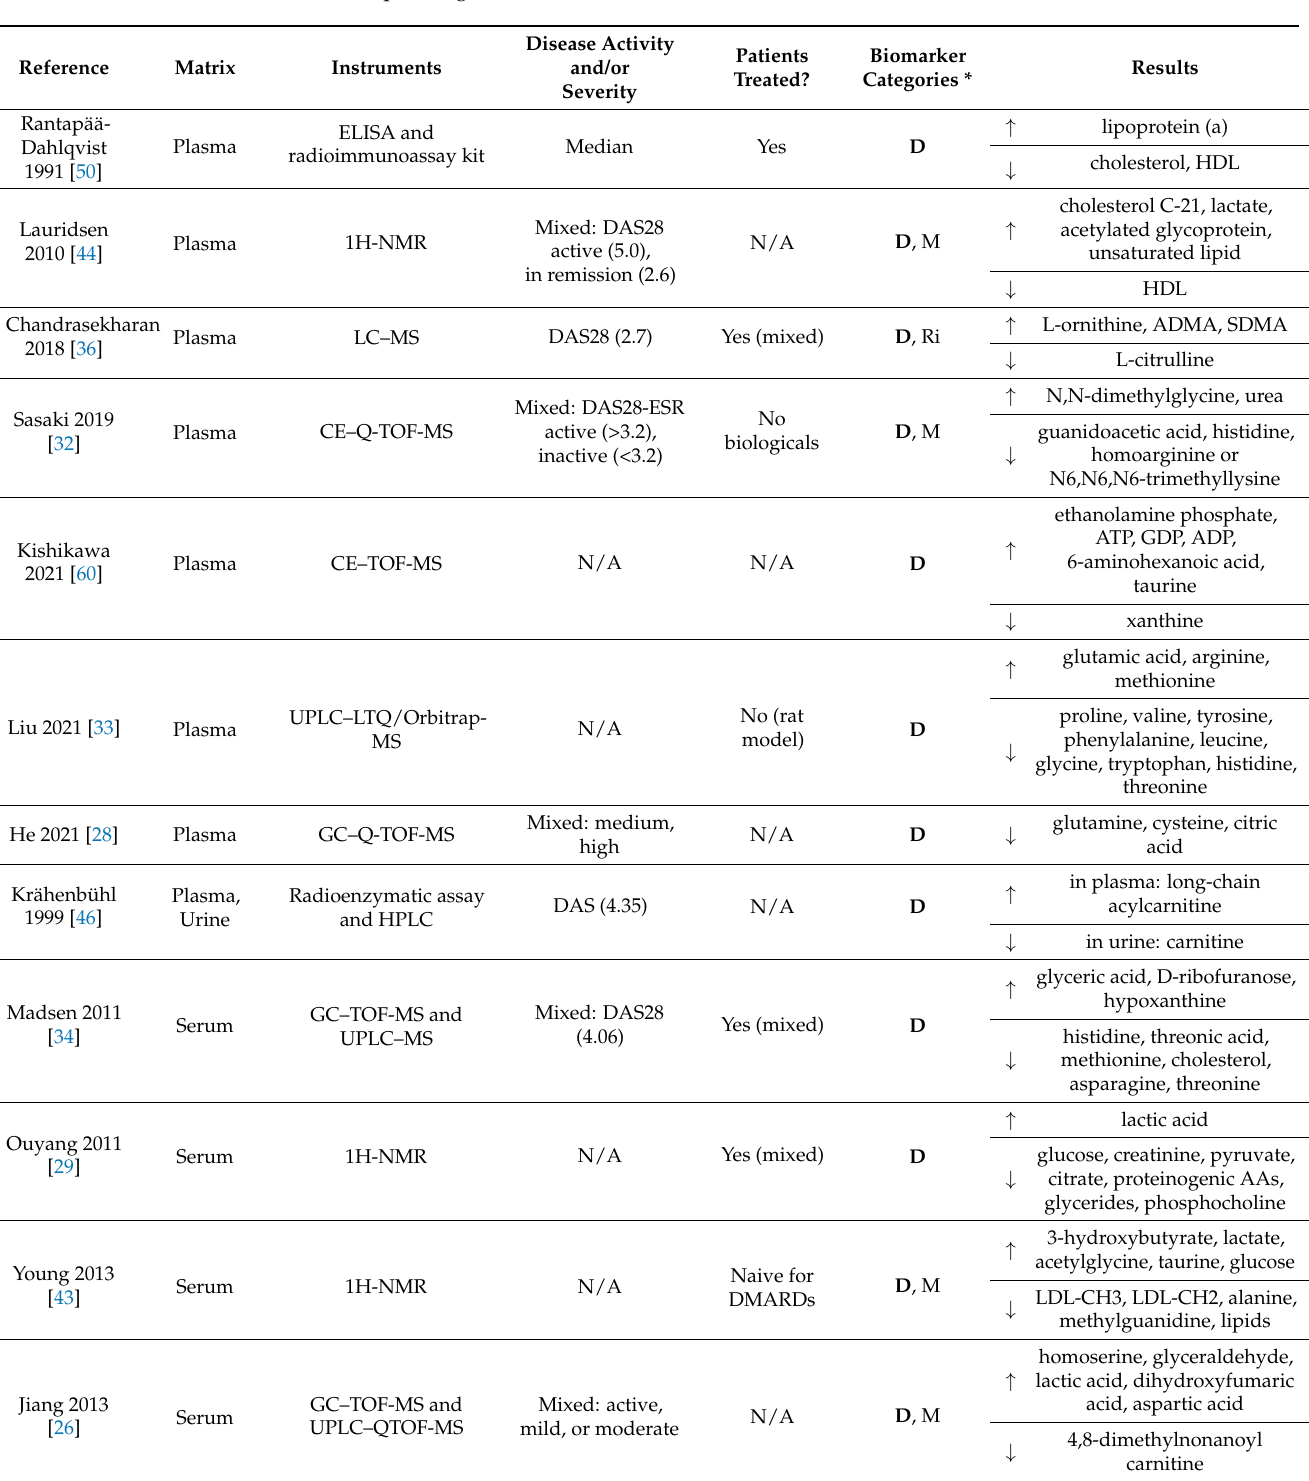
Table 1. Changed metabolites in rheumatoid arthritis (RA). Biomarker category highlighted in bold: Corresponding metabolites listed in column